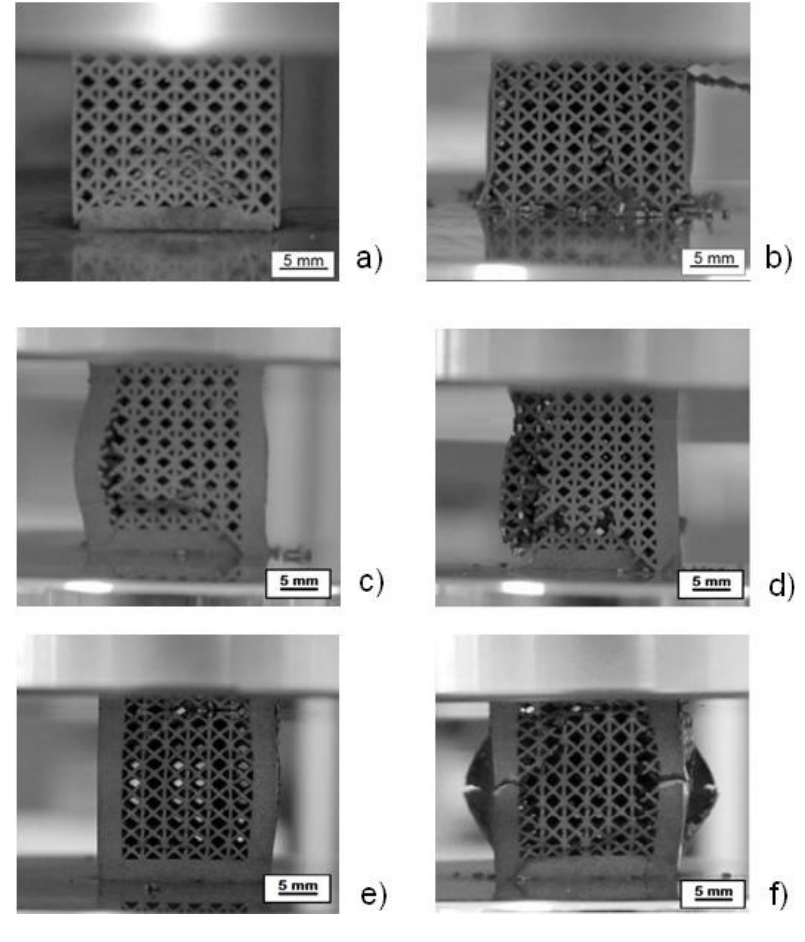
Figure 7. Deformed structure without reinforcements (sample 6) ( a , b ); with four reinforcements (sample 9) ( c , d ); and with eight reinforcements (sample 7) ( e , f